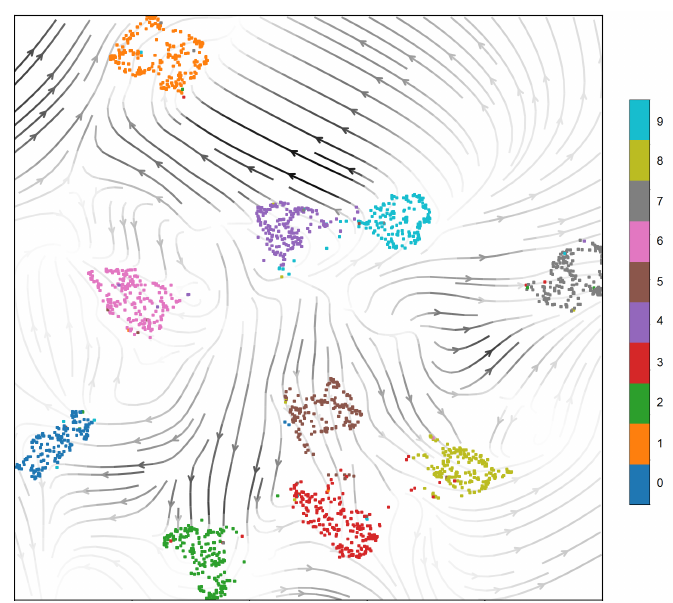
Figure 4. Outputs from the last hidden layer of a 4-layer MLP after 20 training epochs, using MNIST test data input, projected over streamlines. Streamlines are calculated based on three other outputs from the same layer during training, at epochs 0, 1, and 3. Activity between projections is turned into a vector field, which is then used to generate streamlines that offer additional insight into data flow during training without displaying points from other projections. For streamlines, color intensity represents flow speed (L2 norm of vectors) and arrows indicate direction.